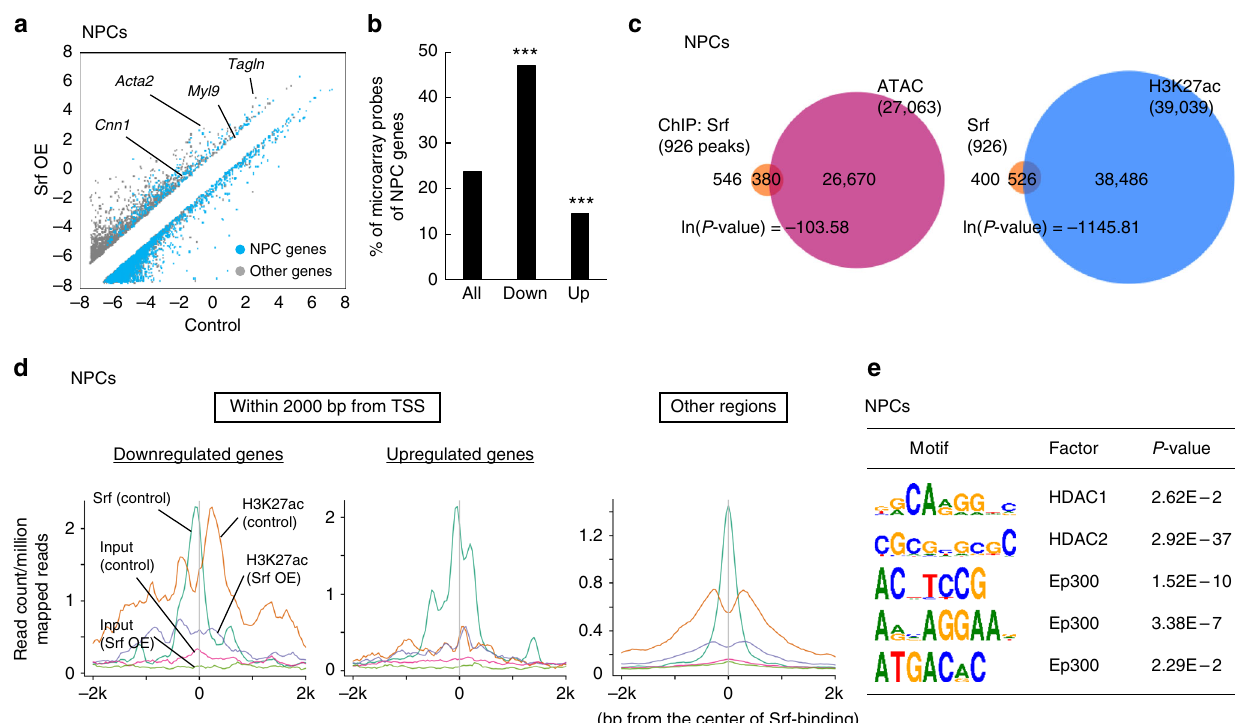
Fig. 4 Srf preferentially downregulates cell-type-speci fi c genes. a A scatter plot showing gene expressions that are > 2-fold different between Srf - overexpressing NPCs and control cells. Blue dots show NPC genes, which are de fi ned as genes whose expression levels in NPCs are > 2-fold compared with those in ESCs. b Cell-type-speci fi c genes are enriched in genes downregulated by Srf overexpression. Asterisks indicate a signi fi cant difference between genes in the indicated group and all other genes (two-sided Fisher ’ s exact test; *** P < 0.0005). c Srf preferentially binds to open and H3K27ac- marked genomic regions. The peak number in the overlapped area is based on the number of Srf-binding peaks. Overlaps were analyzed by the hypergeometric test. d Srf removes adjacent H3K27ac in NPCs. Means of ChIP-seq signals around genomic regions to which Srf was bound within 2000 bp from TSS (left panels) and other regions (right panel). e Matrices of consensus binding motifs of HDACs and Ep300 are enriched near Srf-binding sites. Motif analyses of ChIP-seq data of Srf in NPCs indicated that matrices of the motifs of HDAC1, HDAC2, and Ep300 were enriched within 25 bp of the Srf- binding sites in NPCs. Fisher ’ s exact test